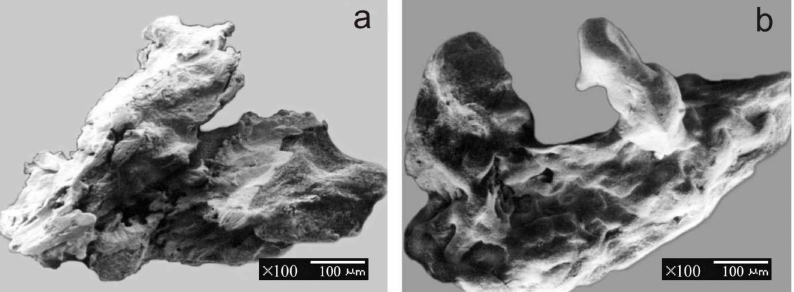
Figure 6. Transformation of a gold particle of ore-appearance in an air–sand flow: ( a ) before the experiment; ( b ) after a 100 h stay in an air–sand flow.